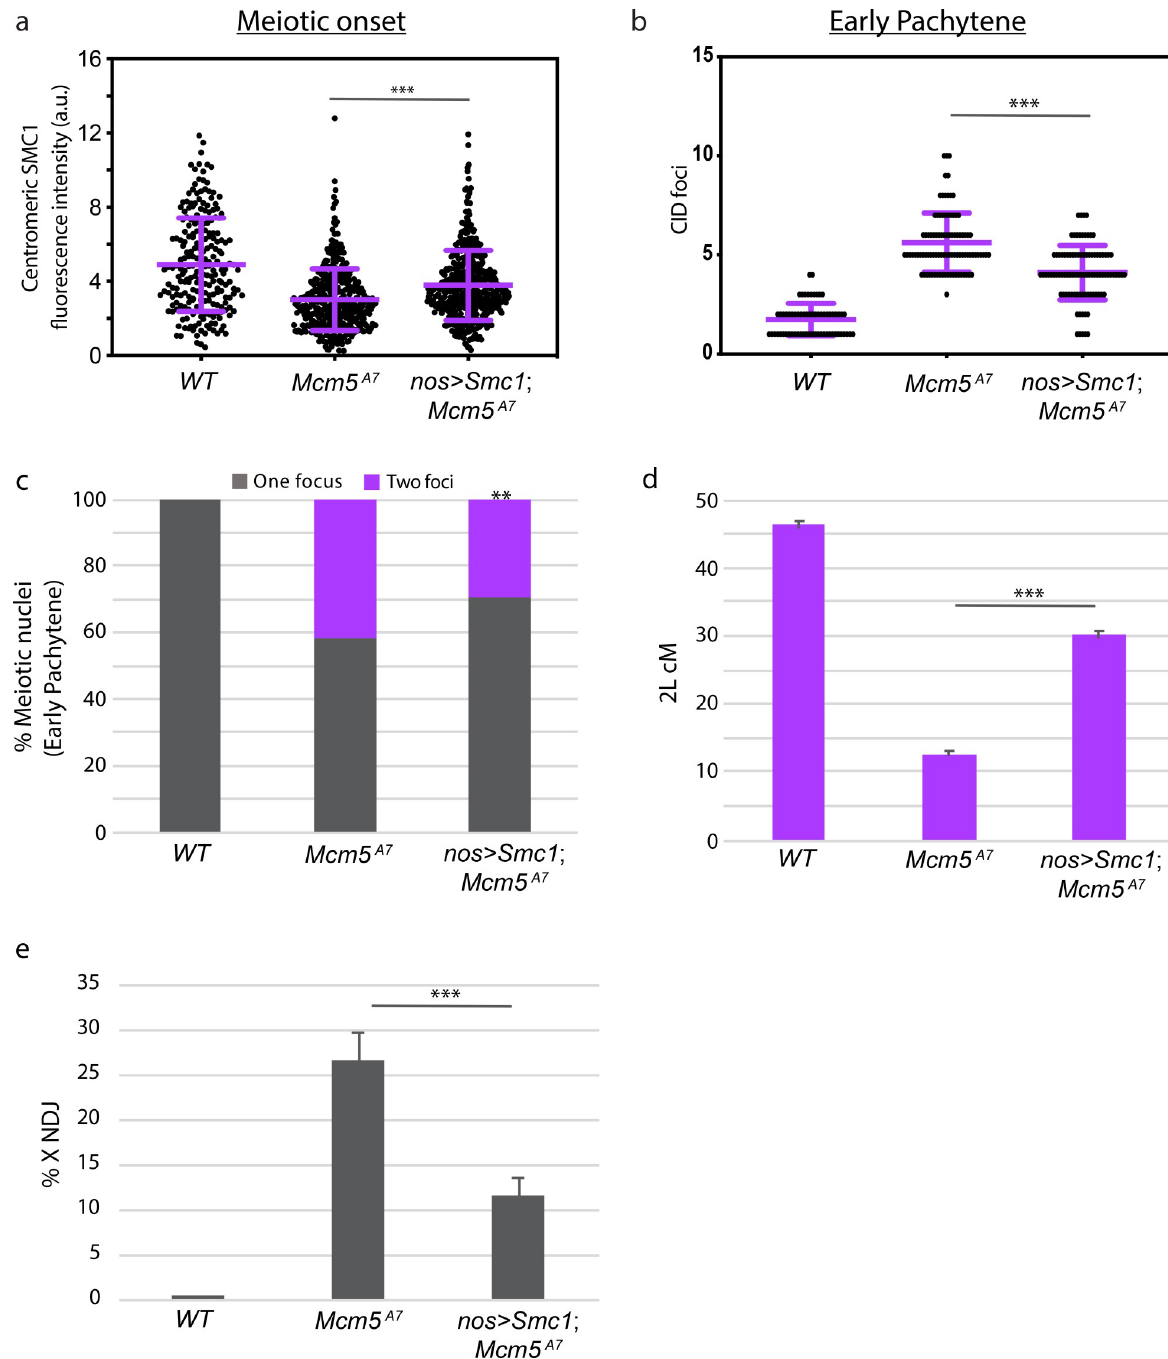
Fig 6. Overexpression of SMC1 in Mcm5 A7 mutants rescue clustering, pairing, crossover formation, and NDJ. a. Integrated SMC1 fluorescence intensity at WT , Mcm5 A7 , and nos > Smc1; Mcm5 A7 ( n = 427) meiotic centromeres at meiotic onset. See S4A Fig for representative images of nos > Smc1; Mcm5 A7 nuclei. WT and Mcm5 A7 data are repeated from Fig 5. ��� p < 0.0001, unpaired T-test. Data are represented as mean ± SD. b. Number of centromeres (CID foci) in WT , Mcm5 A7 , and nos > Smc1; Mcm5 A7 ( n = 94) meiotic nuclei at early pachytene. WT and Mcm5 A7 data are repeated from Fig 2. ��� p < 0.0001, unpaired T-test. Data are represented as mean ± SD. c. Percent of total paired and unpaired in WT , Mcm5 A7 , and nos > Smc1; Mcm5 A7 (total n = 169) nuclei at early pachytene, combining X -probe and 3 R-probe data. WT and Mcm5 A7 data are repeated from Fig 4 and are represented as X -probe plus 3 R-probe early pachytene data. Significance comparing Mcm5 A7 and nos > Smc1 , Mcm5 A7 : �� p = 0.0002, chi-square d. Crossover levels on chromosome 2 L as shown in cM in WT ( n = 4222) [54], Mcm5 A7 ( n = 2070), and nos > Smc1; Mcm5 A7 ( n = 933). ��� p < 0.001, chi-square. Data are represented as mean ± 95% CI. Refer to S2 Table for full 2 L crossover dataset. e.